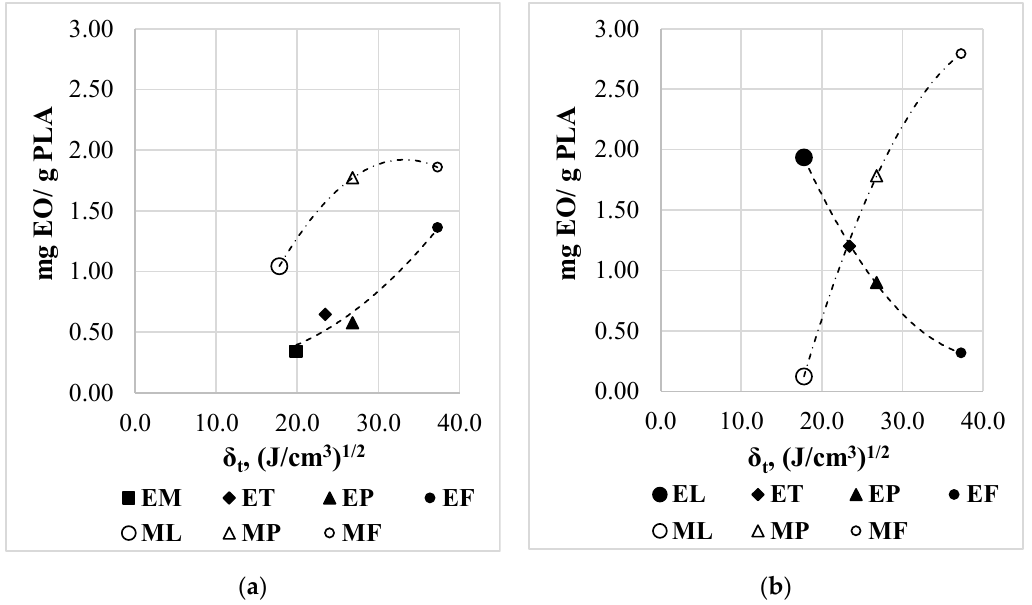
Figure 8. The specific amount of essential oil adsorbed as a function of the solubility parameter of essential oils in the case of sample F in: ( a ) 1.5 wt.% solutions, ( b ) 2 wt.% solutions with ethanol and methanol as a solvent.